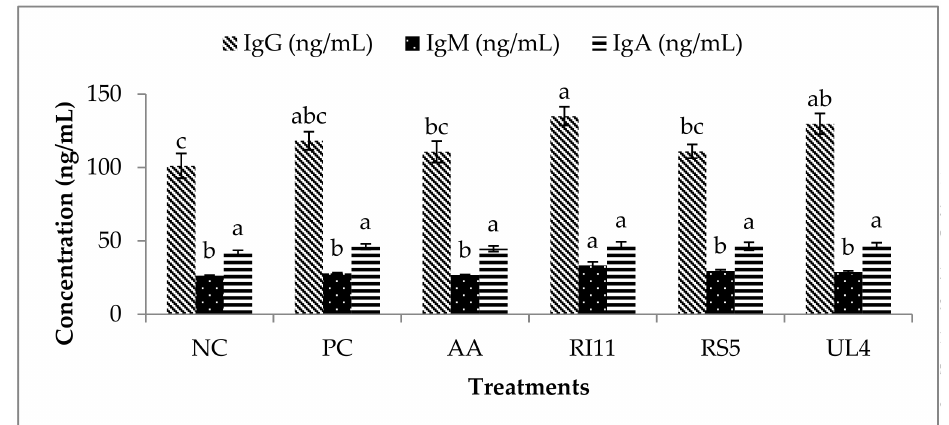
Figure 1. Plasma immunoglobulins in broiler chickens fed di ff erent postbiotics under heat